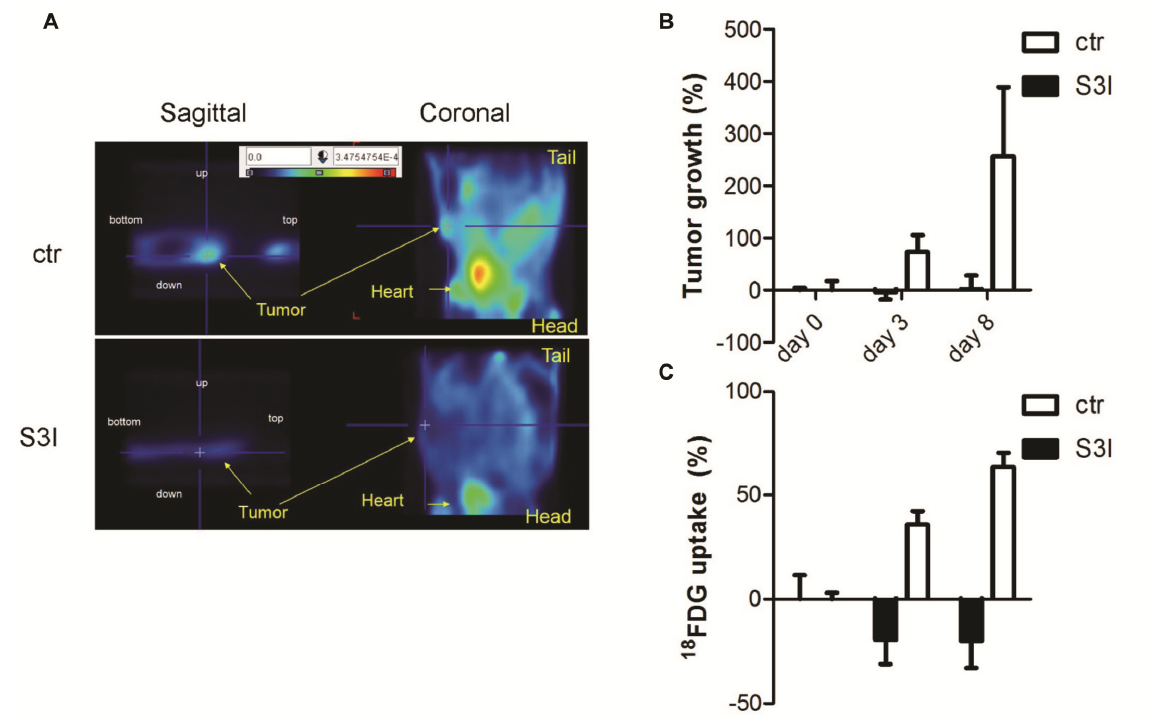
Figure 2. In vivo STAT3-dependent glycolysis of MDA-MB-468 tumor cells, measured by PET analysis as 18 F-FDG uptake. Mice were inoculated with MDA-MB-468 cells and tumors let grow up to 60 mm 3 prior to S3I treatment (day 0). 18 F-FDG was injected and images acquired at days 0, 3 and 8 after the first S3I treatment. ( A ) Representative images (sagittal and coronal sections) of one control and one S3I-treated mouse 8 days after treatment; ( B ) Tumor volumes were measured with a caliper and indicated as percentage of growth relative to day 0; ( C ) The lower graph represents the variation of glucose uptake normalized over tumor volume at the indicated times after the first S3I treatment. Quantitative image analysis of tracer uptake was evaluated by drawing region of interest (ROI) of tumor on the transaxial images. Note decreased glucose uptake at day 3 (d3) and 8 (d8) upon S3I treatment, compared − SUV ) × 100/ SUV to constant tumor volume. % of 18 F-FDG uptake = (SUV d=n d=0 d=0